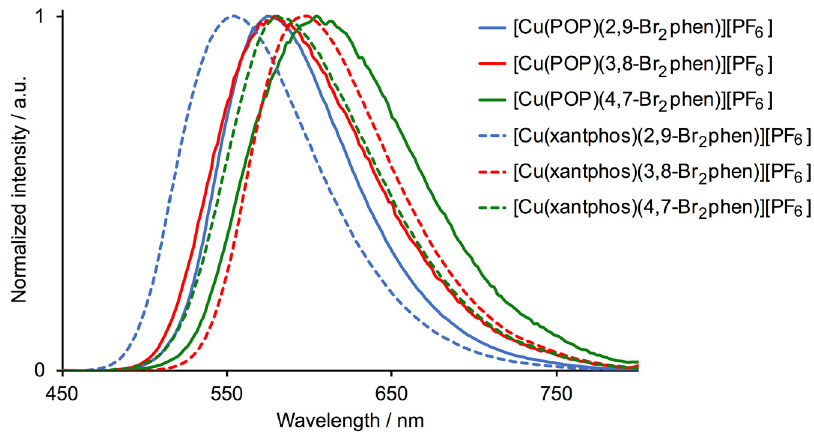
Figure 9. Normalized emission spectra of powder samples of the [Cu(PˆP)(NˆN)][PF 6 ] compounds. See Table 4 for λ exc .